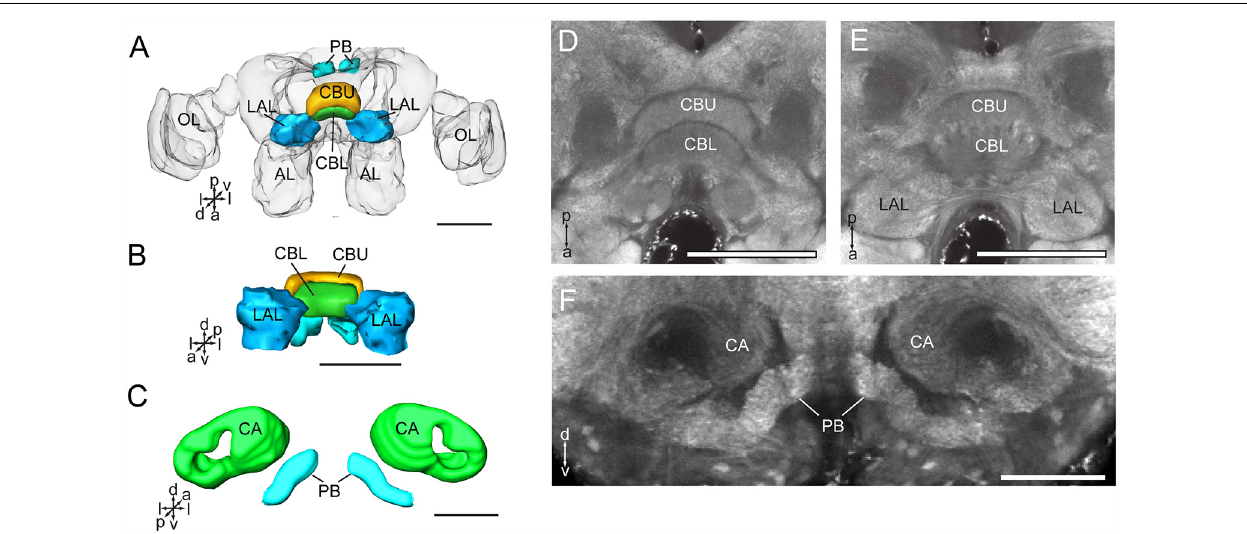
FIGURE 4 | Three-dimensional reconstructions and confocal images of Apolygus lucorum CB, PB, and LAL. (A) Three-dimensional reconstructions of CB, PB, and LAL in dorsal view. (B) Anterior view. (C) Three-dimensional reconstructions of PB and calyces in posterior view. (D) A confocal image showing the CB. (E) A confocal image showing the CB and LAL. (F) A confocal image showing the PB and calyces. AL, antennal lobe; CA, calyx; CBL, lower unit of central body; CBU, upper unit of central body; LAL, lateral accessory lobe; OL, optic lobe; PB, protocerebrum bridge. Directions: a, anterior; d, dorsal; l, lateral; p, posterior; v, ventral. Scale bars: 100 µ m in (A,B,D,E) , 50 µ m in (C,F) .